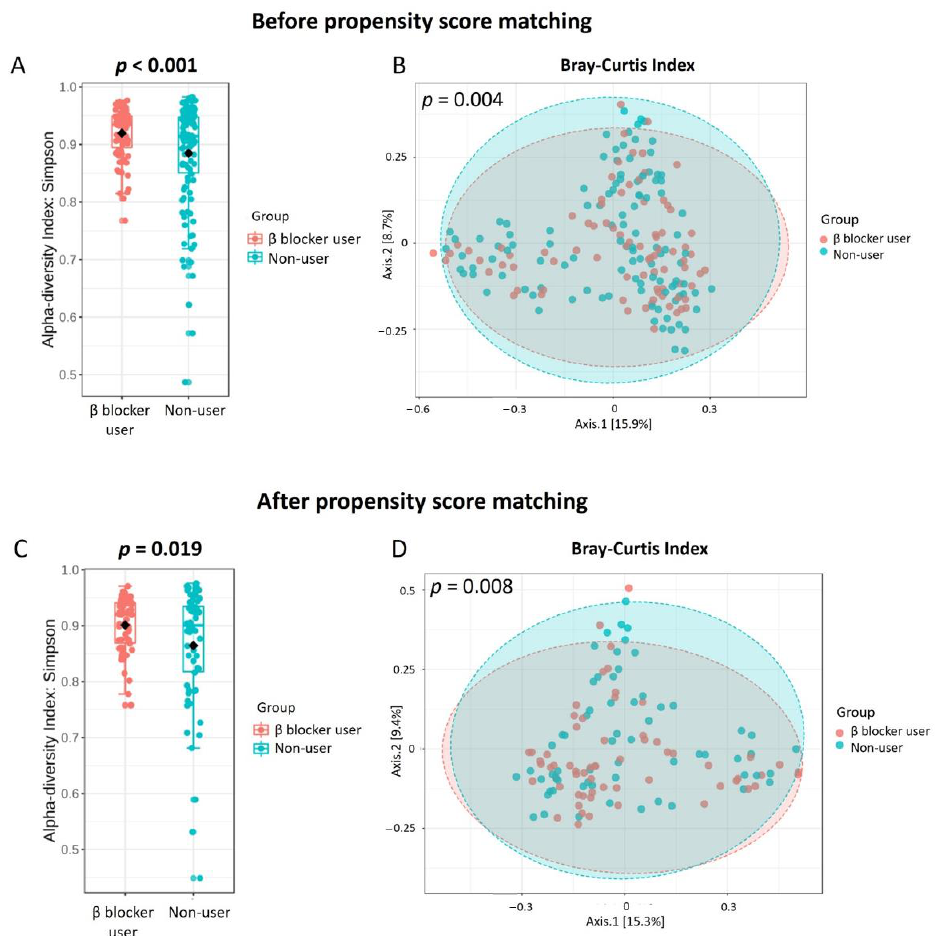
Figure 2 Figure 2. The α -diversity and β -diversity in hemodialysis patients with and without β blocker used in full cohort ( A , B ) and propensity score matching cohort ( C , D ). β blocker users had a higher α -diversity than β blocker nonusers in full cohort ( A ) and propensity score matching cohort ( C ) β blocker users had a different β -diversity (Bray–Curtis index) compared to β blocker nonusers in full cohort ( B ) and propensity score matching cohort ( D ). The β -diversity p -value was calculated using the homogeneity of group dispersions by the Permutational Analysis of Multivariate Dispersions (PERMDISP)